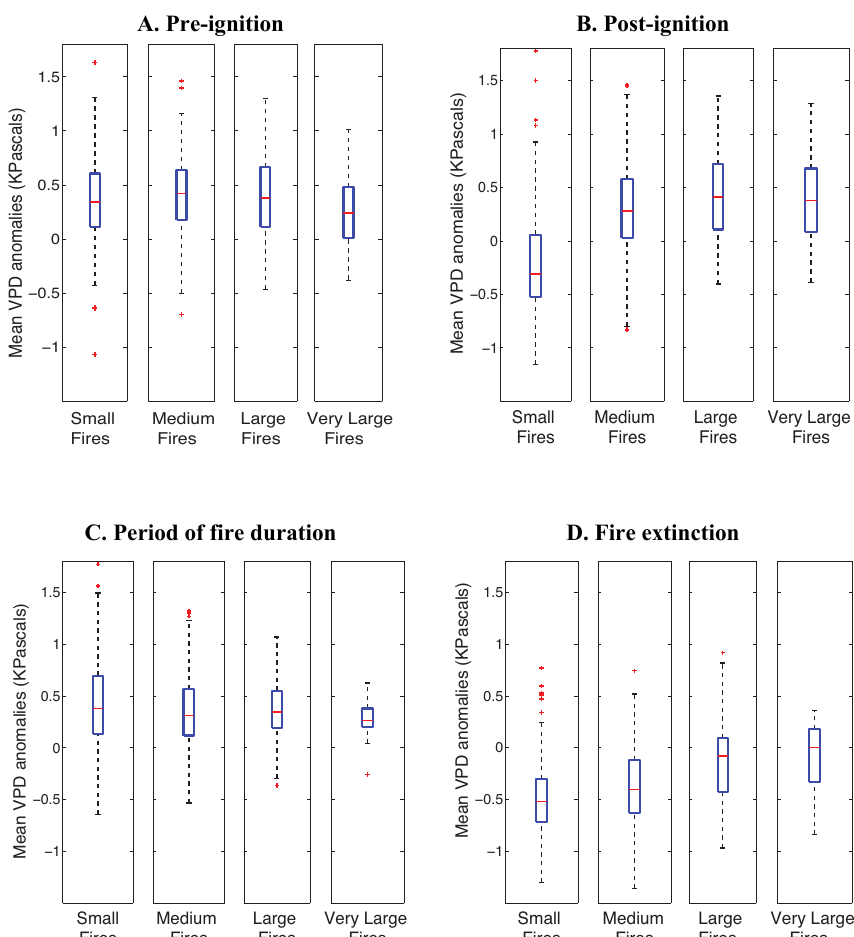
Figure 5. Relationship between VPD anomalies and fire size for different phases of fire growth. Mean VPD anomalies are shown for A) prior to ignition, averaged over 1–5 days before the ignition event, B) immediately after ignition, averaged over 1–5 days after the ignition event, C) during the duration of each fire (i.e., between the ignition and extinction events), and (D) during extinction, defined as the 1–5 days after the last satellite active fire observation was detected within or near the fire perimeter. Mean VPD anomalies for fire size classes were significantly different ( z test, 0.05 significance